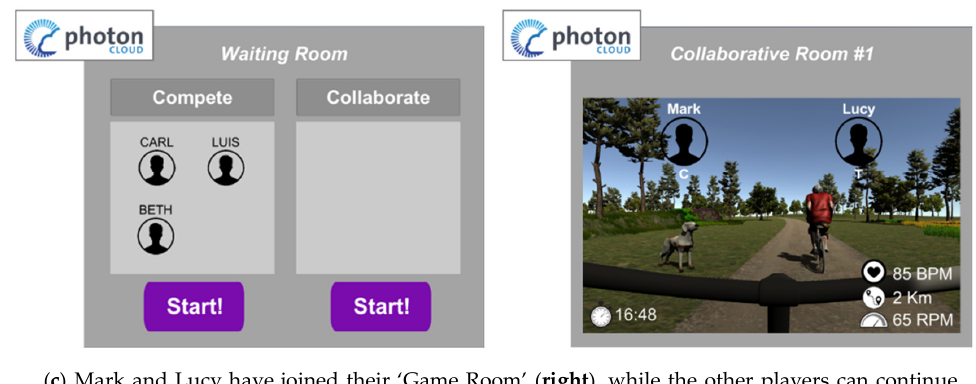
Figure 4. An exemplificative representation of the application flow.